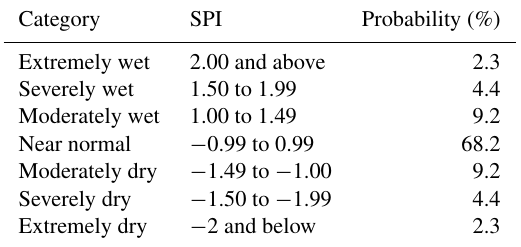
Table 3. Drought classification based on SPI according to McKee